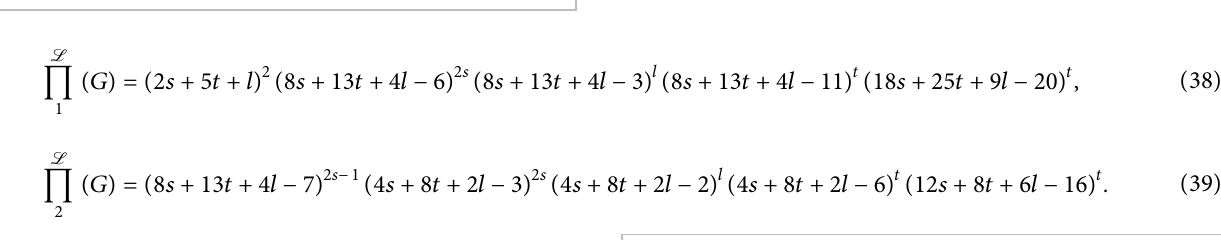
Figure 2: Firefly graph F